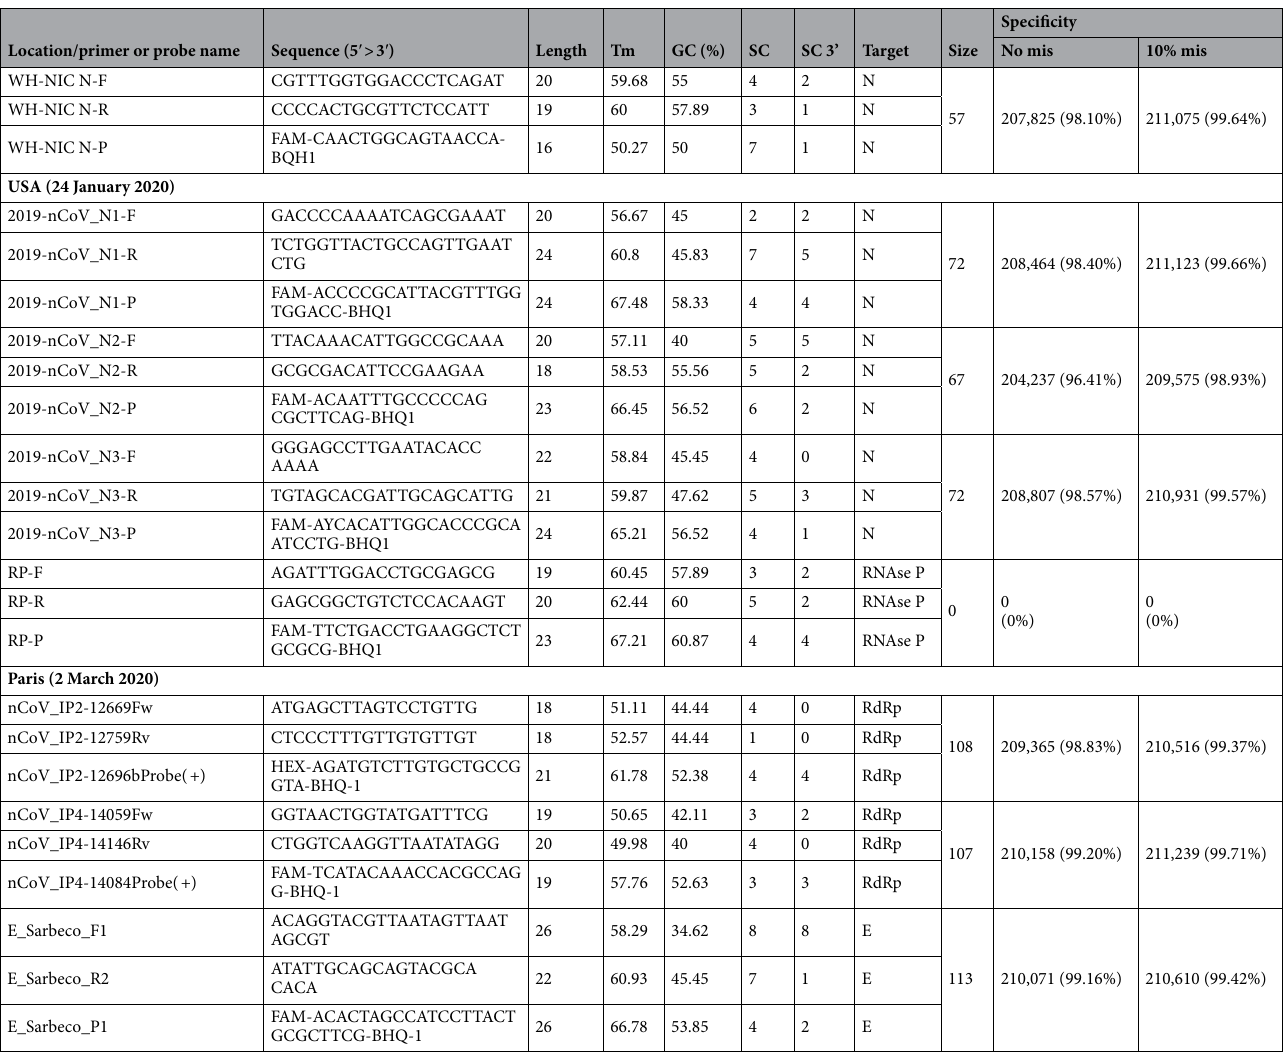
Table 2. Primers released by WHO to detect SARS-CoV-2 using polymerase chain reaction. The percentage of the total number of sequences that annel without mismatches or allowing 10% mismatches are shown in parentheses. F forward primer; R reverse primer; P probe; Tm melting temperature; GC% G + C percentage; SC self complementarity; SC 3 ’ self 3’-complementarity; No mis number of sequences that anneal to the primer without mismatches; 10% mis number of sequences that anneal to the primer allowing 10%